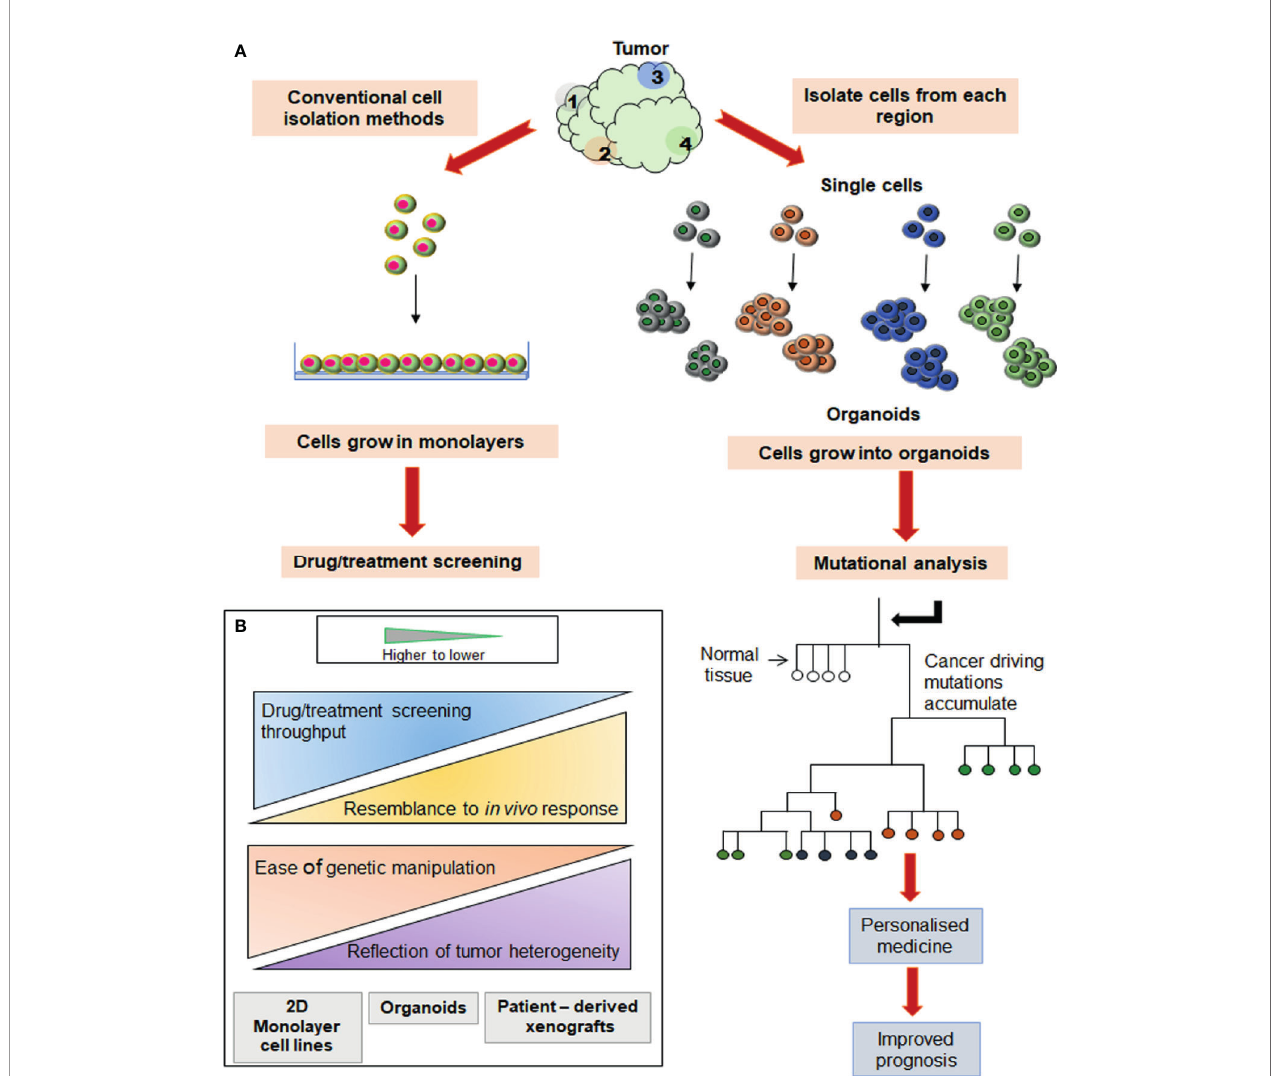
FIGURE 1 | Comparison between two different cell culture systems initiated from the same source. (A) Cells isolated from various tumor sites are grown in 2D and 3D culture systems, and their trajectories are tabulated on the right and left side, respectively. Analysis of mutations in each organoid grown from a single cell may be used to construct the phylogenetic tree. (B) When compared to PDXs or slice cultures, the 3D cultures are amenable for easier manipulation, identi fi cation of heterogenous population, and high throughput screening